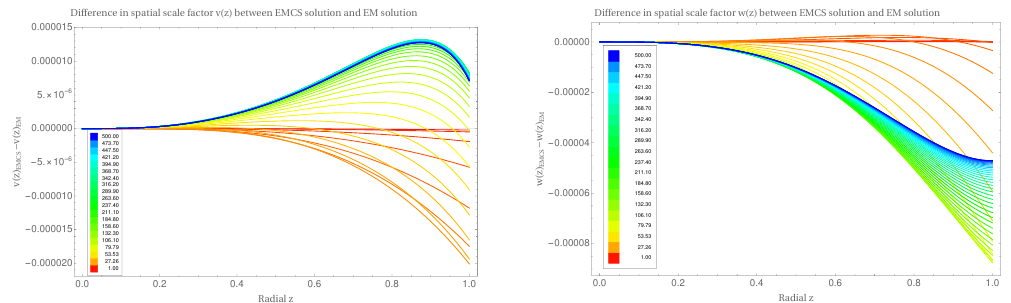
Figure 21 . We display the difference between the blackening factor for full solutions to Einstein- Maxwell-Chern-Simons theory and solutions to the Einstein-Maxwell theory. The inset legend displays the coloring for different values of B/T 2 . The difference between these spacetimes can be seen to be very large deep in the bulk as we move towards B/T 2 (cid:29) 1 .